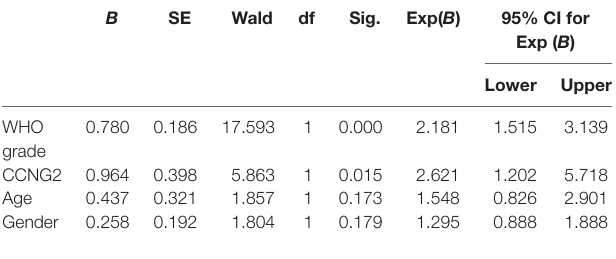
Table 2 | Wilcoxon rank sum test of the relationship between CCNG2 expression in human glioma tissues and clinicopathological features. B